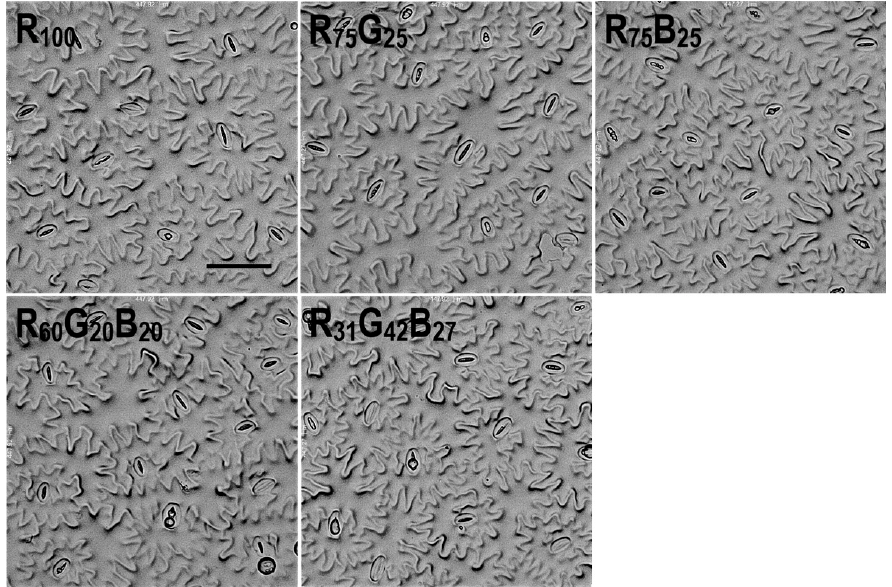
and significance at p < 0.001, respectively.